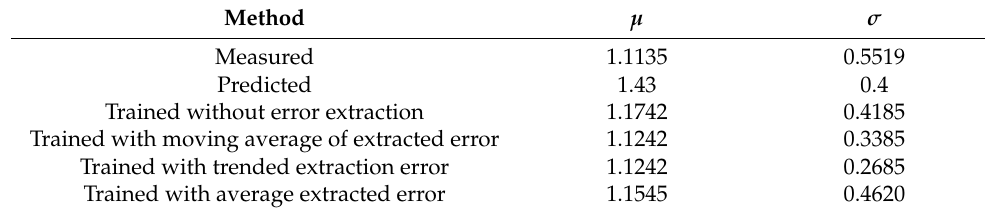
Table 6. Comparison of implemented methods.